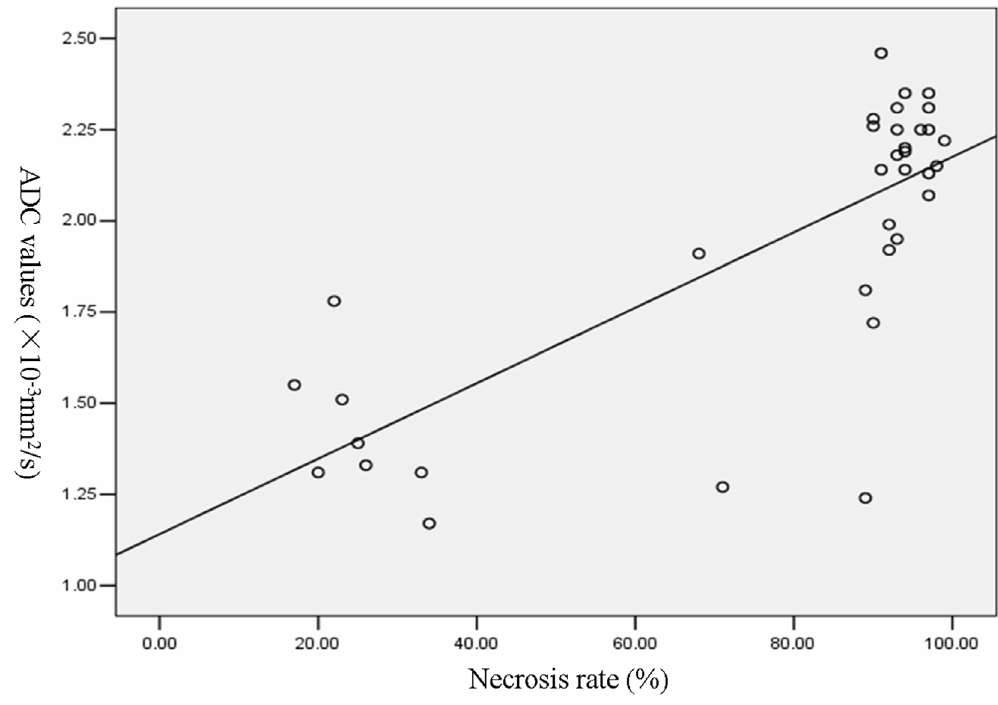
Figure 4. Correlation of ADC values of the whole osteosarcomas with necrosis rates after neoadjuvant chemotherapy.